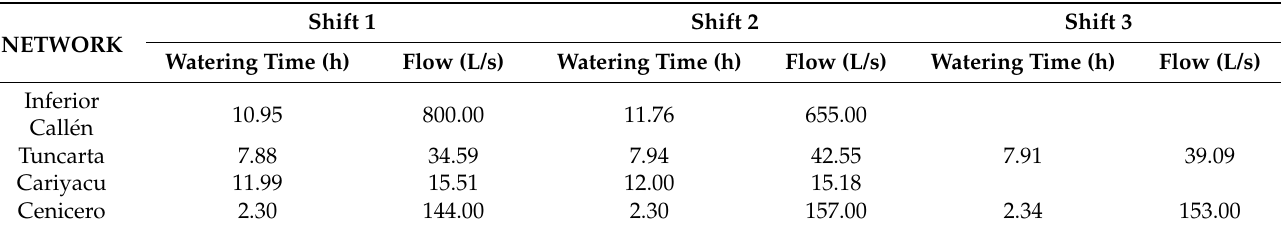
Table 4. Irrigation times per shift and transfer flows (study networks).